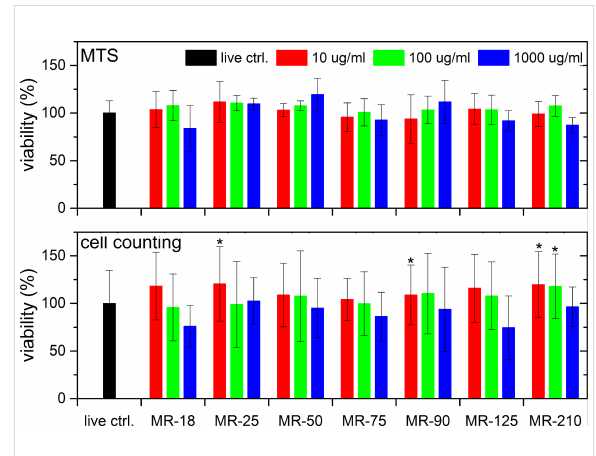
Figure 1: Viability of SAOS-2 cells incubated with HPHT NDs for three concentrations as a function of the mean particle diameter after 3 days. (Upper row) results of an MTS assay, (lower row) results of cell counting after cell staining. The results are given as the mean ± SD from 3 experiments, each performed in sextuplicate. ANOVA, Tukey HSD post-hoc test. “*” indicates a significant difference from MR-18 at a concentration of 1000 µg/mL ( p <